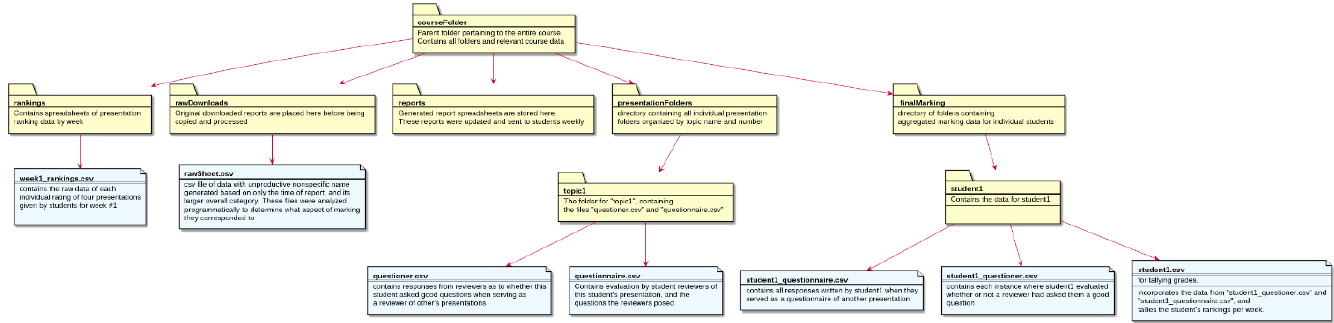
Figure A2. Flow chart of folder structure.